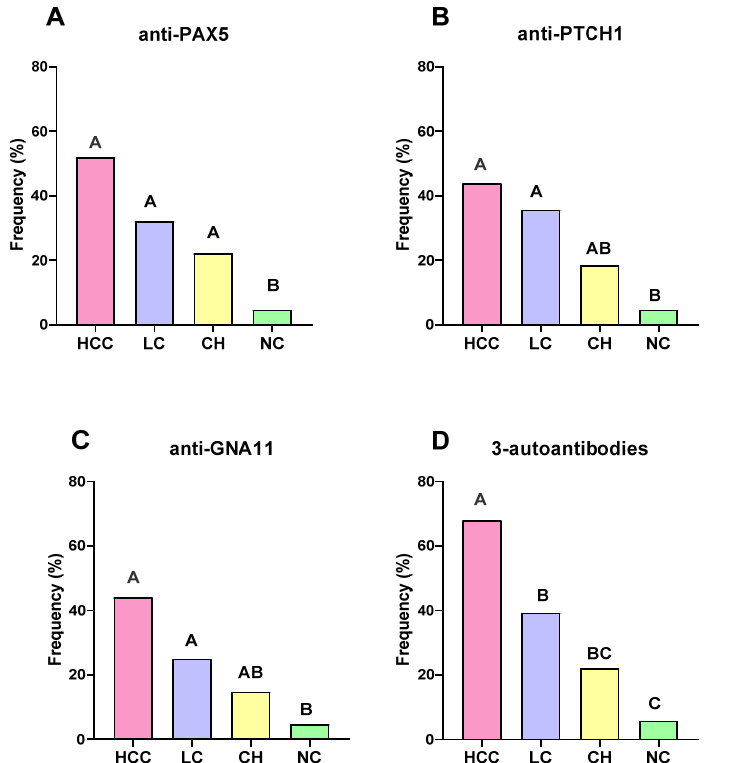
Figure 2. Frequencies of autoantibodies to PAX5 ( A ), PTCH1 ( B ), GNA11 ( C ) , and the combination of these three autoantibodies ( D ) in different study subjects. HCC, hepatocellular carcinoma; LC, liver cirrhosis; CH, chronic hepatitis; and NC, normal controls. The significant difference was indicated if the letters above the bars are totally different (e.g.,: A > BC, A > B, A > C, B > C).